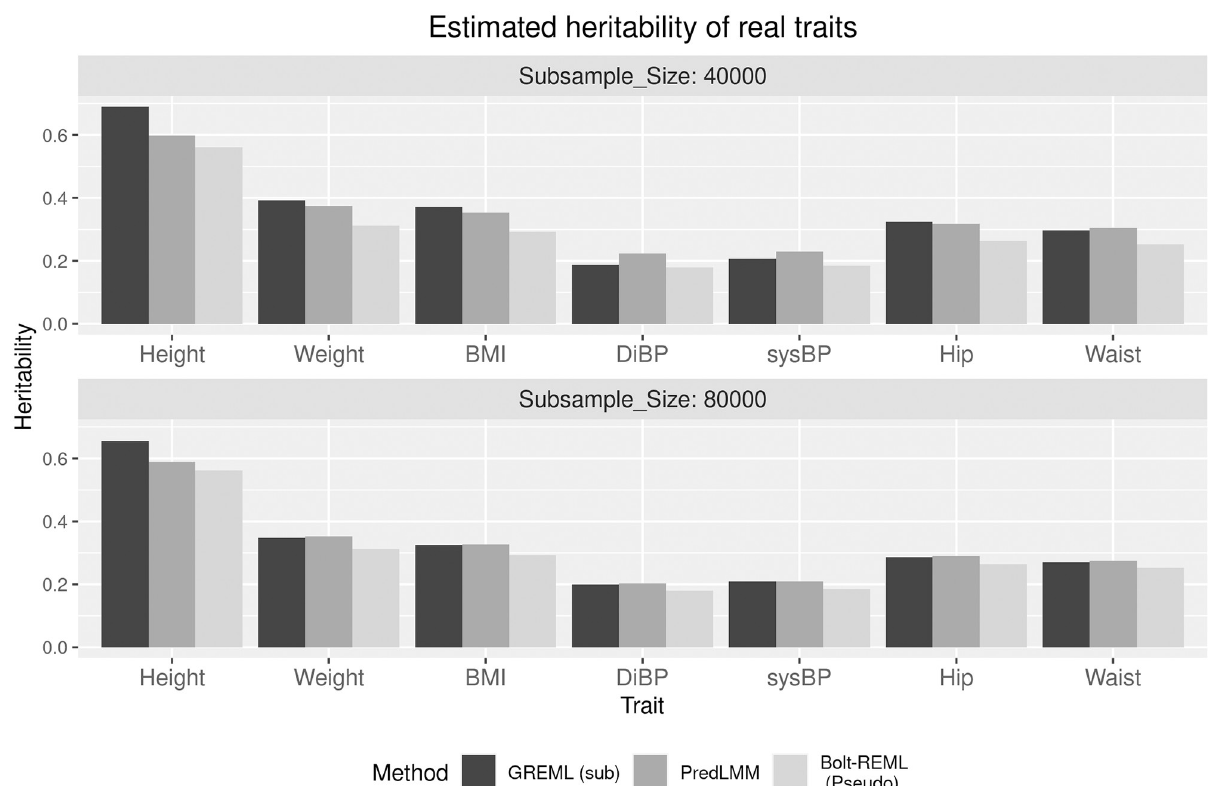
Fig 6. The figure shows the bar-plot of the heritability estimates by PredLMM and GREML (sub) with two sub-sample (knot) sizes and by Bolt- REML (pseudo) for seven different real traits.